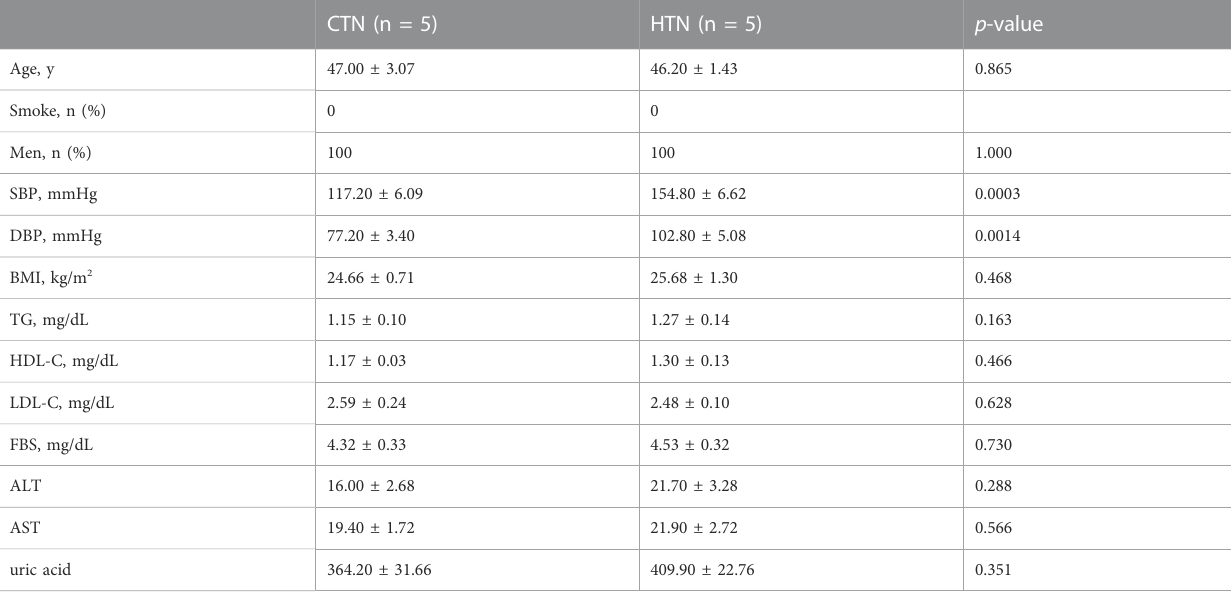
TABLE 1 Basic characteristics of normotensive controls and hypertensive patients for single-cell RNA